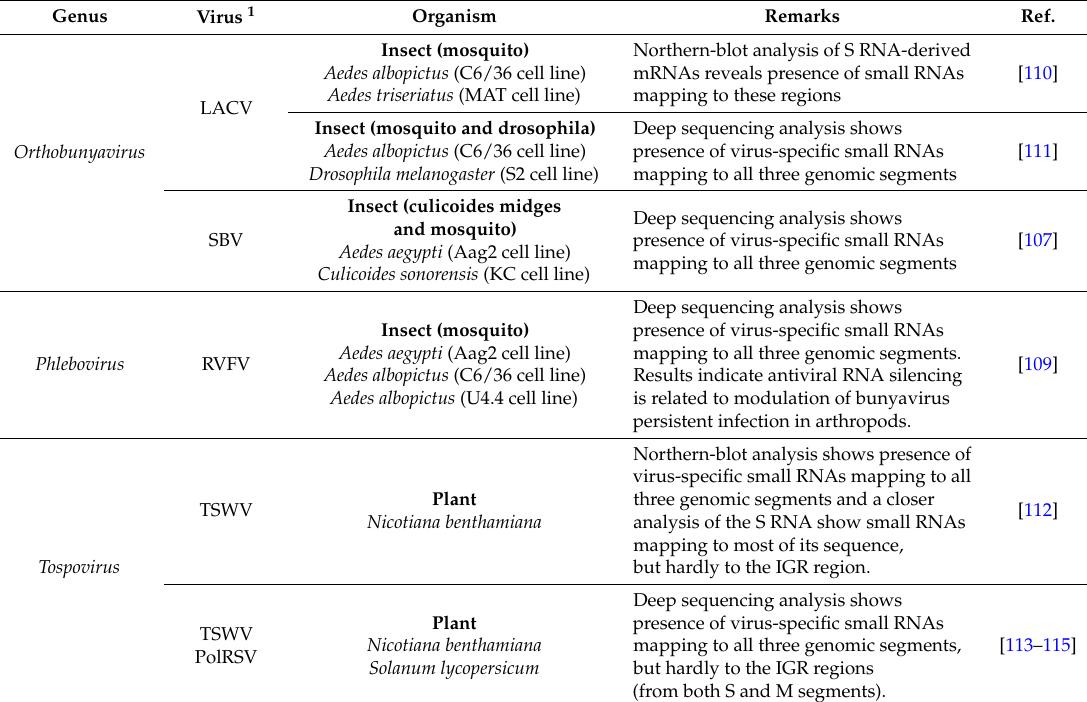
Table 2. Reports on RNA silencing responses and production of virus-derived siRNAs during infection with members of